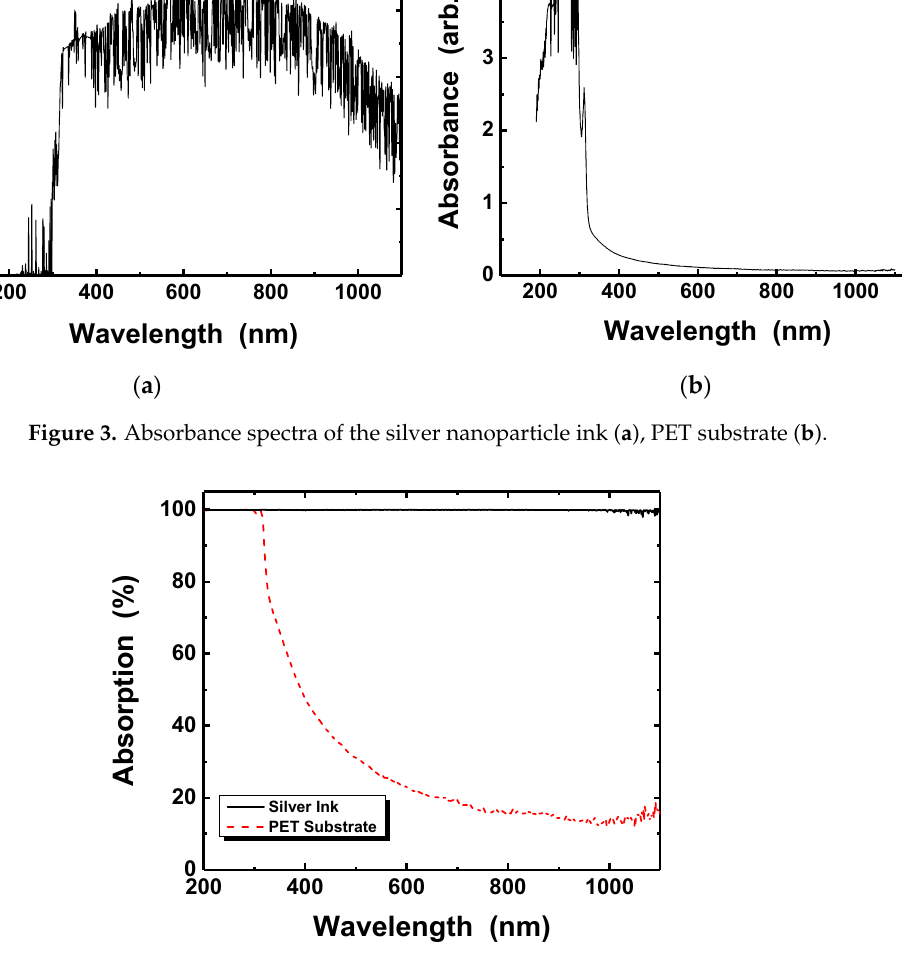
Figure 4. Optical absorption spectra of Ag nanoparticle ink and PET substrate.